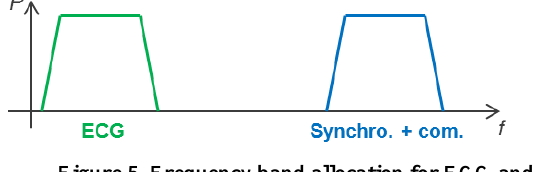
Figure 5. Frequency band allocation for ECG